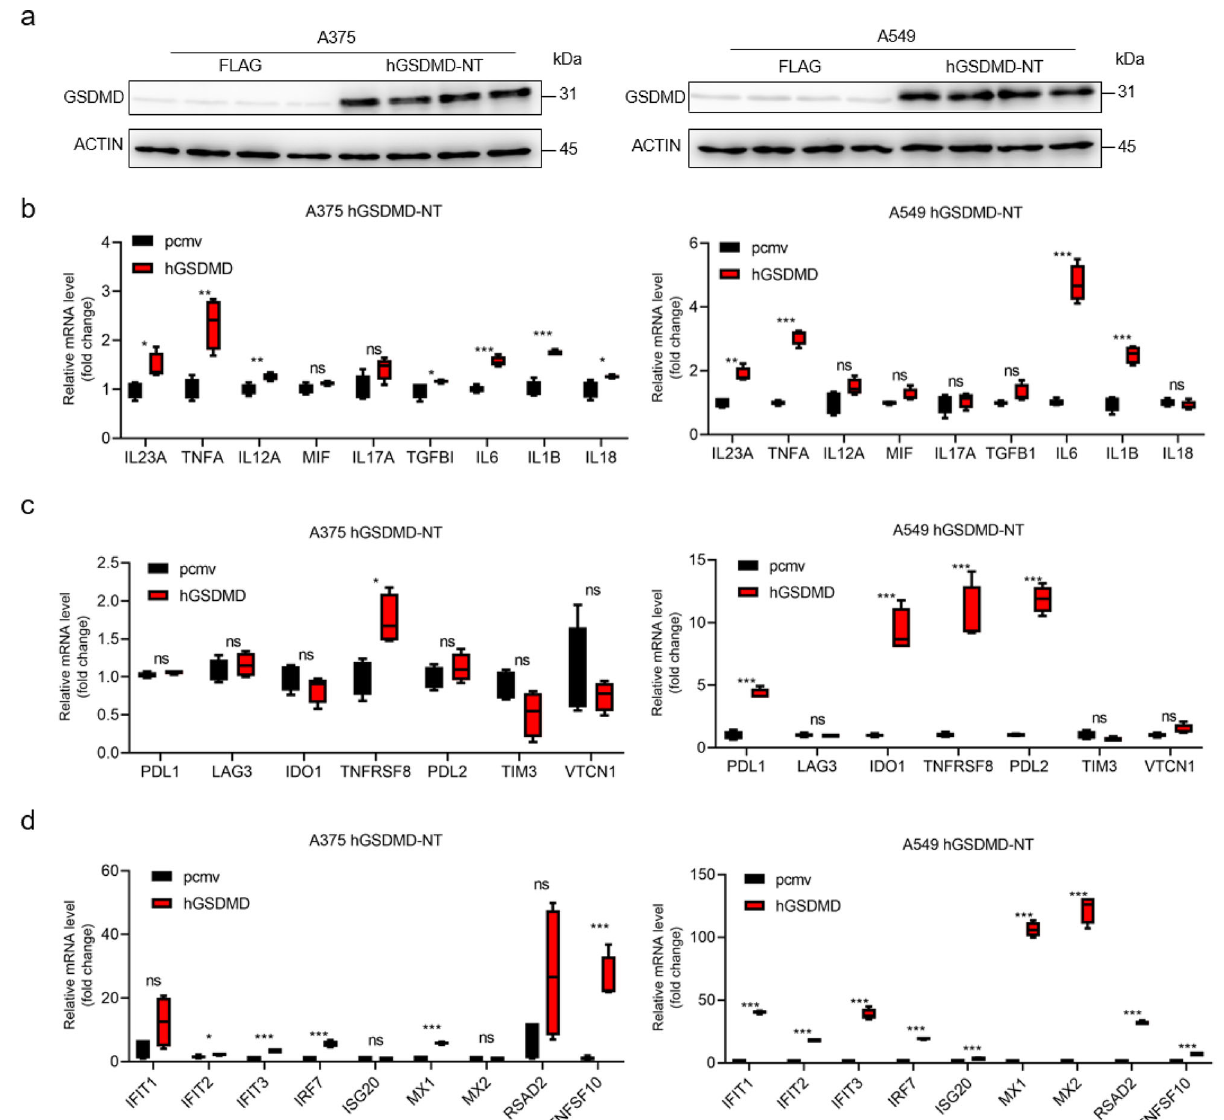
Fig. 3 Pyroptosis altered immune activity in cancer cells. a Western blot assay showing the successfully upregulated GSDMD-NT by GSDMD-NT plasmid transfection. b qPCR analysis of in fl ammatory cytokines gene expression in A375 and A549 cell lines with GSDMD-NT plasmid transfection or its control. GAPDH was used as an internal control for qPCR analysis. c qPCR analysis of immune checkpoint-related genes expression in A375 and A549 cell lines with control or GSDMD-NT plasmid. d qPCR analysis of the Type I TNF response pathway-related genes expression in A375 and A549 cell lines with control or GSDMD-NT plasmid. Data was mean ± Standard Deviation (SD). P values were calculated using the Spearman correlation test or Student ’ s t-tests after the assessment of normality ( n = 4/group, * P < 0.05; ** P < 0.01; *** P <